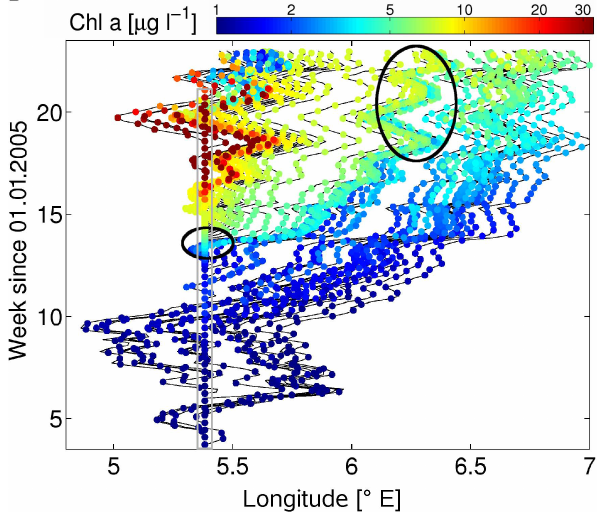
Fig. 8. Model trajectories coloured according to their simulated CHL- a values; all particles are released at 5 . 4 ◦ E. The small ellipse marks the eastward inflow of a water mass with elevated phyto- plankton concentrations; the big grey circle indicates the fate of the first particles released within the small circle that later in the spring bloom form the border between a high and a low CHL- a region.